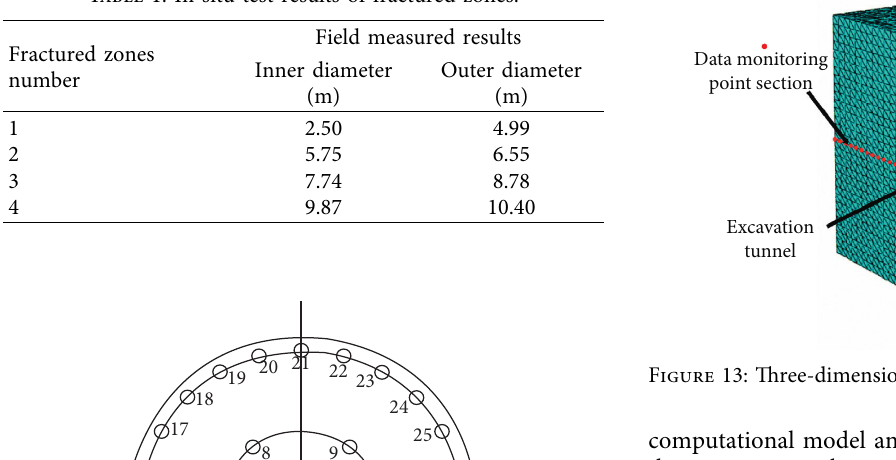
Table 1: In situ test results of fractured zones.